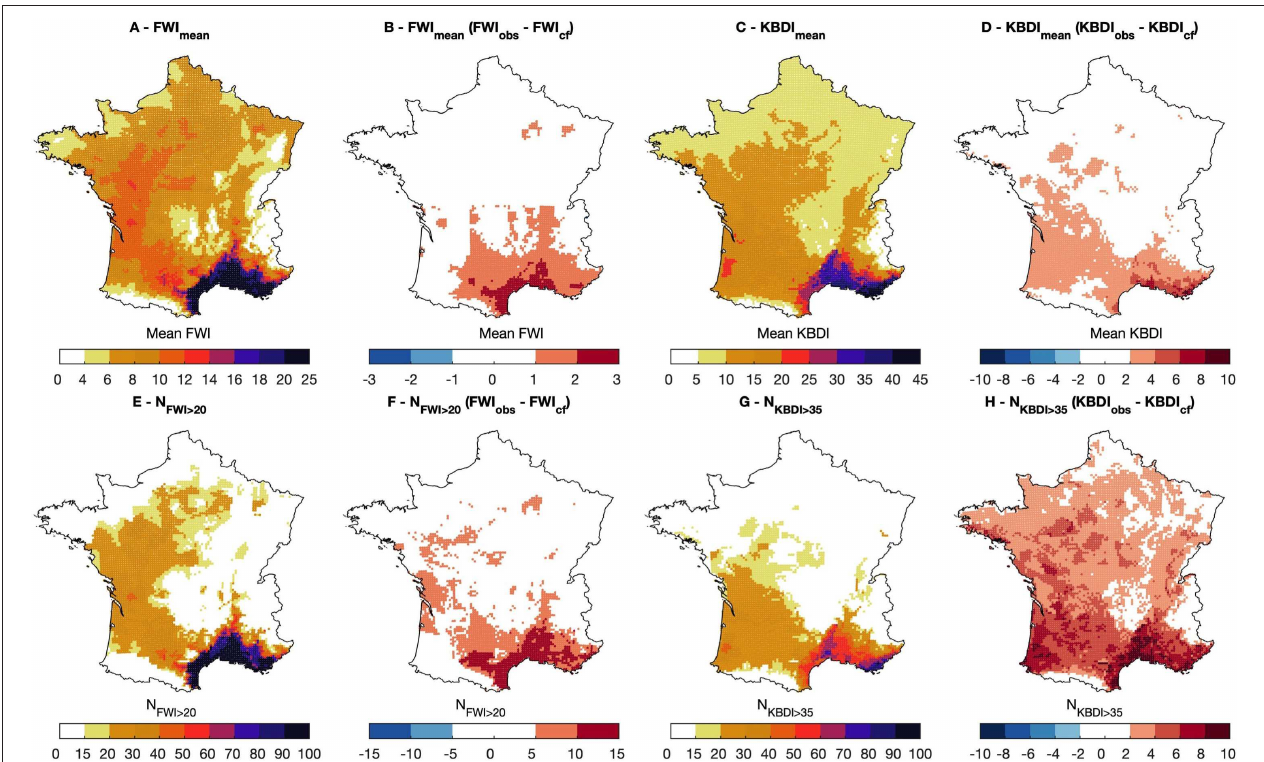
FIGURE 2 | (A) Mean observed FWI from May-September during the last 10 years of the observational record (2008–2017). Note the non-linear color scale. (B) Difference between observations and counterfactual observations as deduced from the multimodel mean during the last 10 years of the observational record (2008–2017). (C) Same as (A) but for mean observed KBDI. (D) Same as (B) but for KBDI. (E) Average number of annual occurrence of daily FWI>20 during the last 10 years of the observational record (2008–2017). (F) Same as (B) but for the annual occurrence of daily FWI>20. (G) Same as (C) but for the annual occurrence of daily KBDI>35. (H) Same as (F) but for